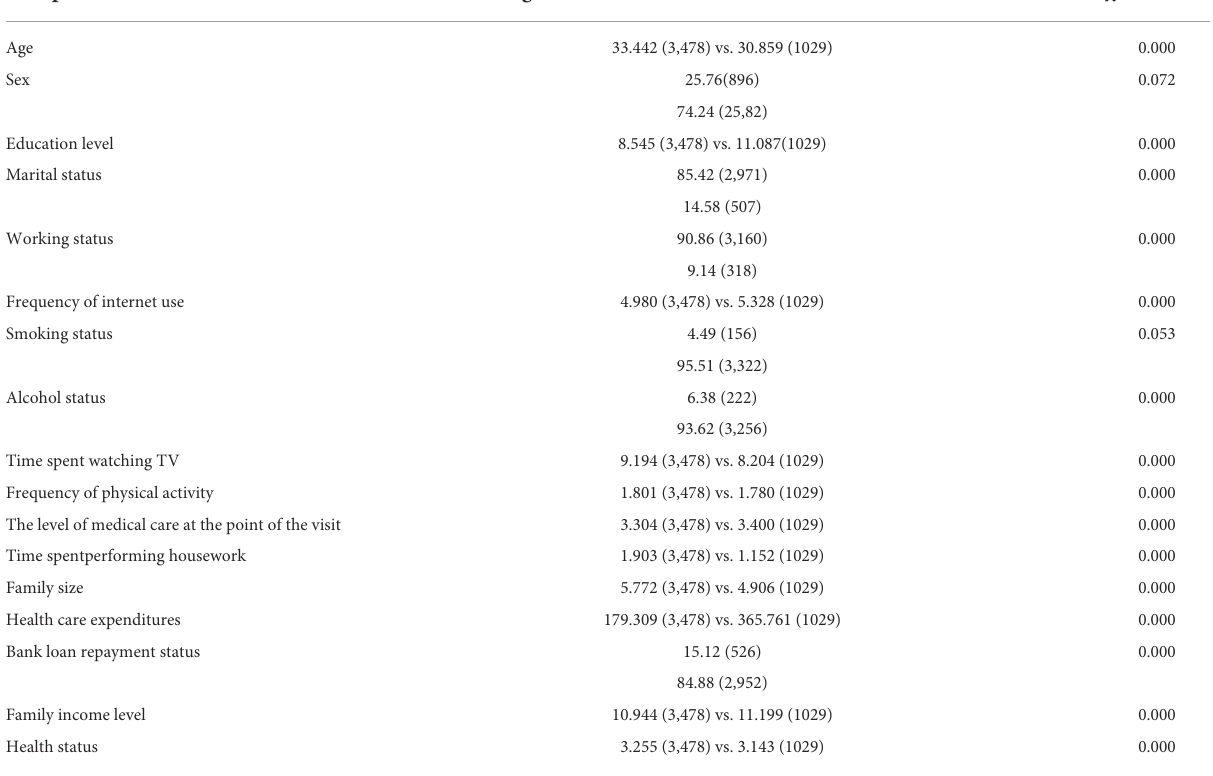
TABLE 3 The result of selection bias of participation in the NRCMS. Comparison